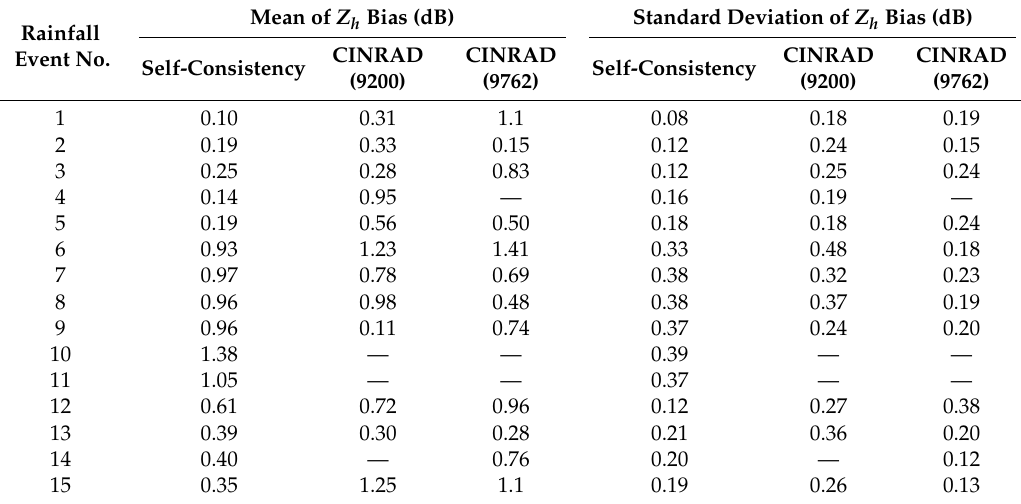
Table 5. Mean and standard deviation of Z h bias by the self-consistency approach and the two closest